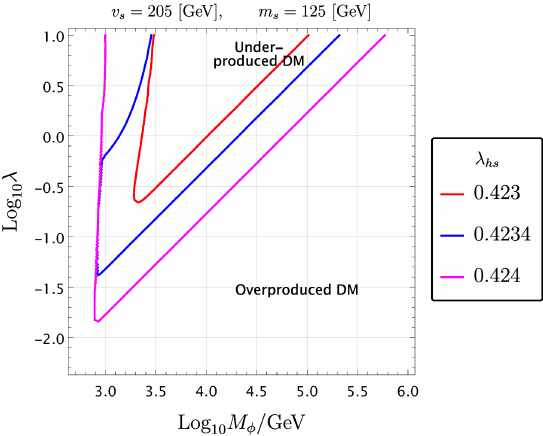
Figure 7 . DM production for the singlet portal model. In this context, the Boltzmann suppression ∼ e − m s /T nuc plays a strong role and allows for bubble expansion produced DM with much higher nucleation temperature T nuc ∼ 15